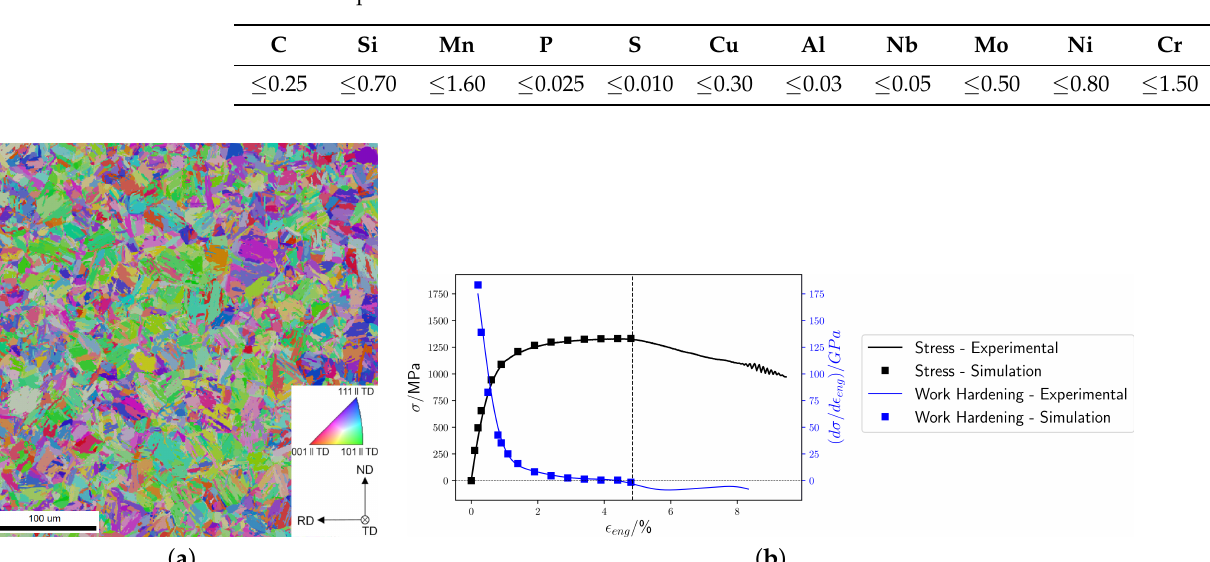
Table 1. Nominal chemical composition of the martensitic steel in wt%. Conventional quenching was used to produce lath martensite.